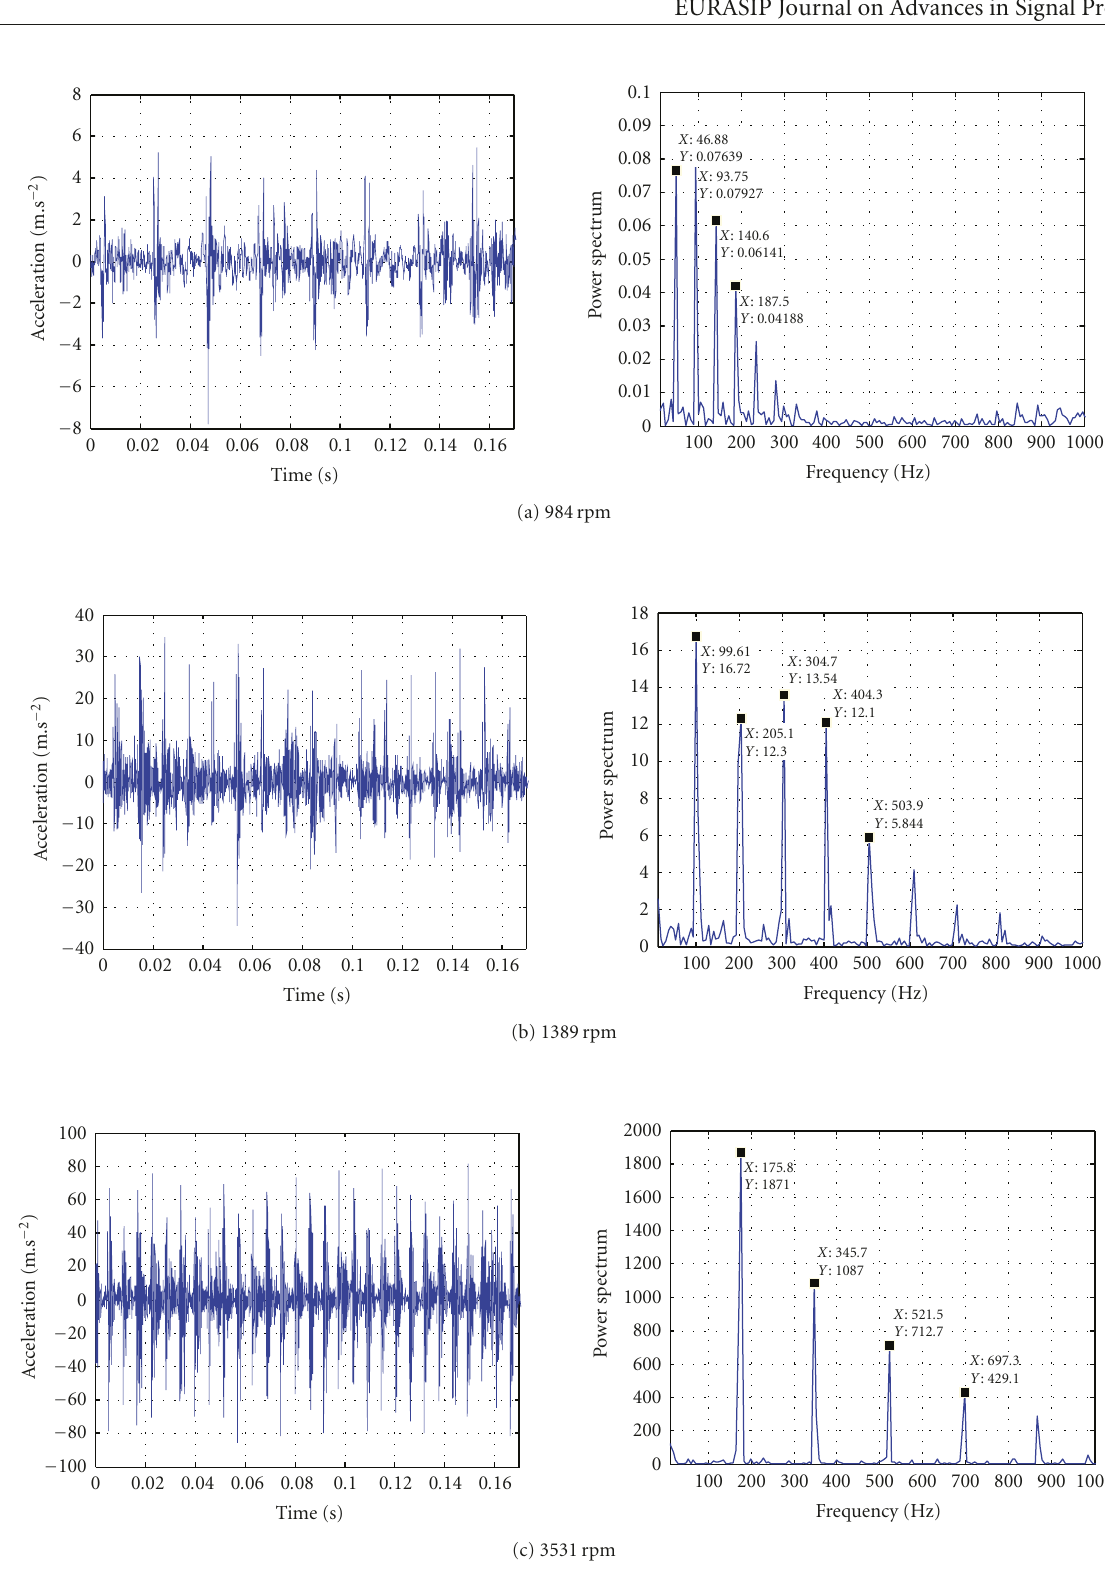
Figure 9: The measured vibration signals for rolling bearing with outer-race fault at di ff erent shaft rotational speed (a) 984rpm, (b) 1389 rpm, and (c) 3531